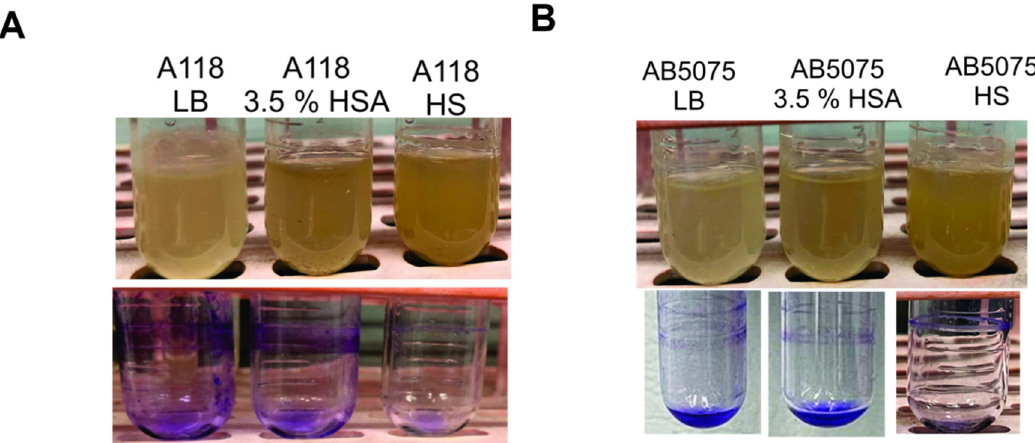
Figure 5. Effect of human serum albumin (HSA) and pooled normal human serum (HS) on biofilm formation in A. buamannii . Biofilm assays performed in A118 ( A ) and AB5075 ( B ) strains grown in LB, LB supplemented with 3.5% HSA, or in HS. Tubes were stained with 1% crystal violet.